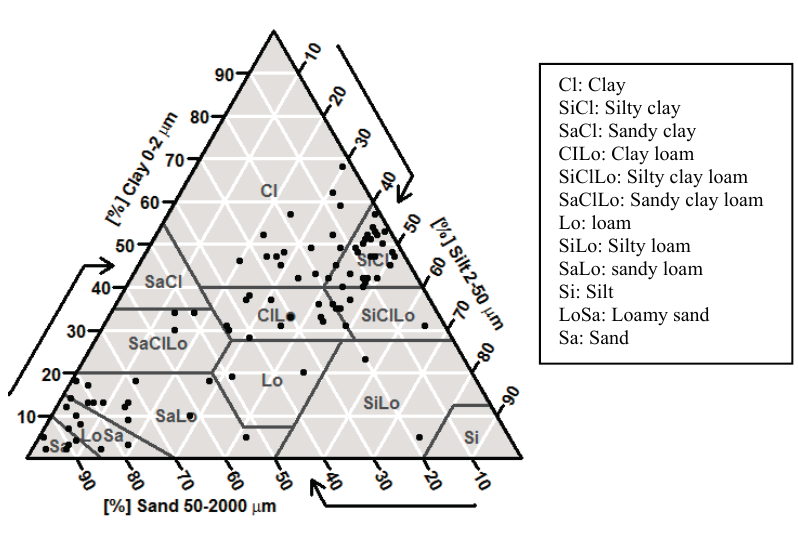
Figure 2. Distribution of 100 analyzed soil samples over the Kairouan plain across the USDA soil textural